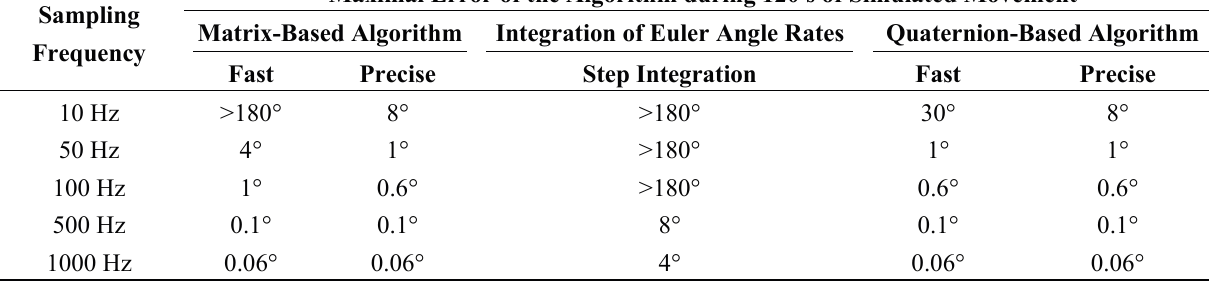
Table 3. Accuracy of the